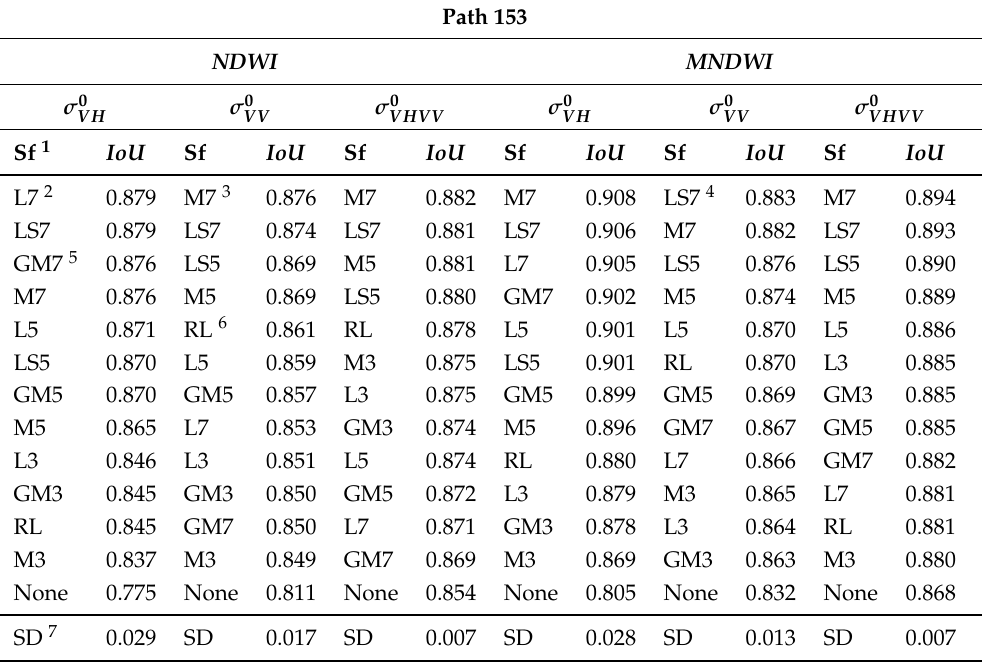
Table 2. Tables of median IoU similarity values for all combinations of speckle filtering